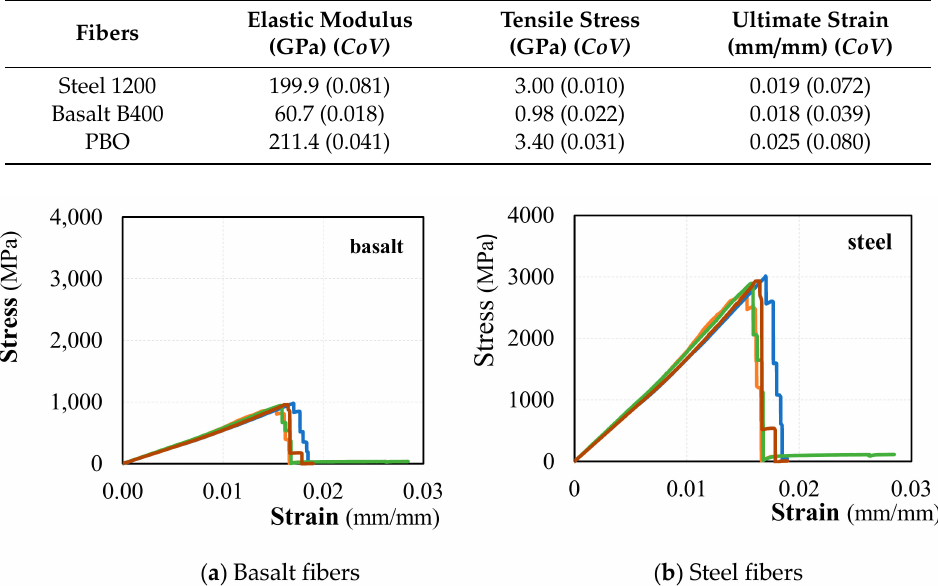
Table 2. Mechanical properties of the steel, basalt and PBO fibers.